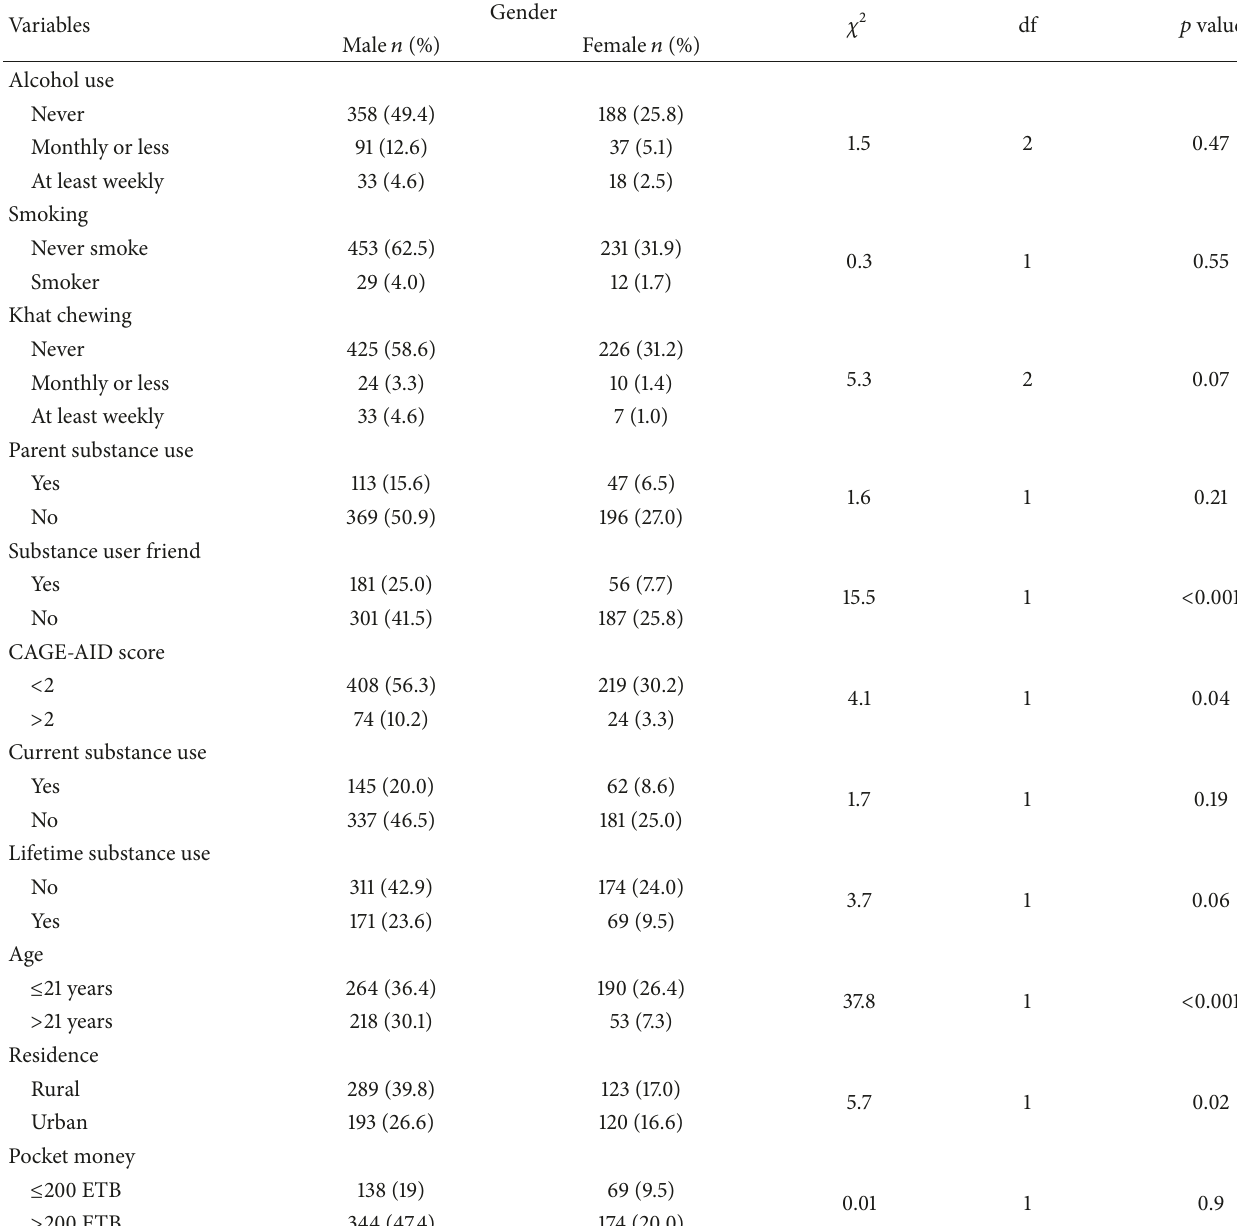
Table 3: Substance use and some selected variables of students with respect to gender, 2015.